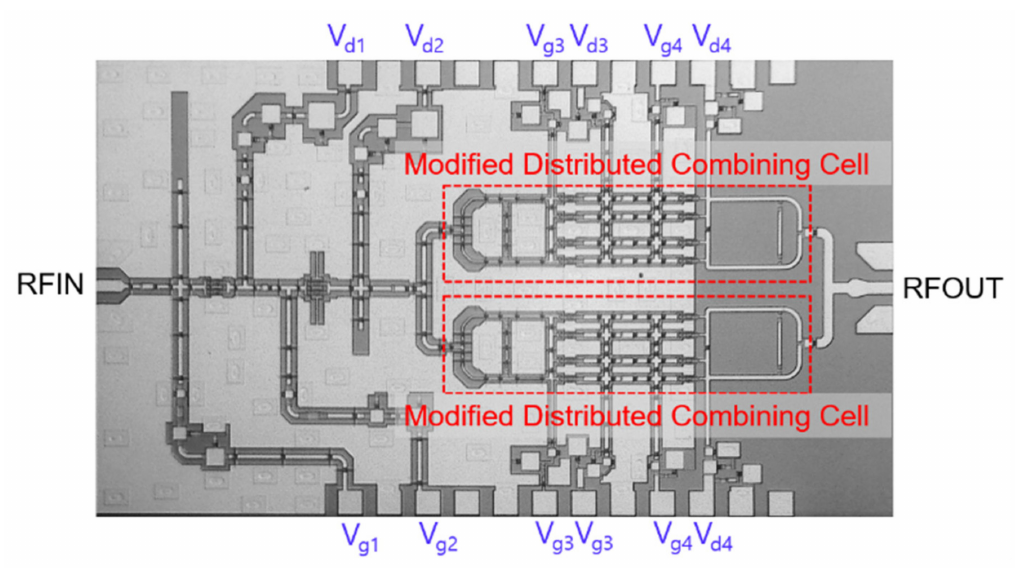
Figure 7. Die photograph of the proposed PA (chip size: 3.1 mm × 1.7